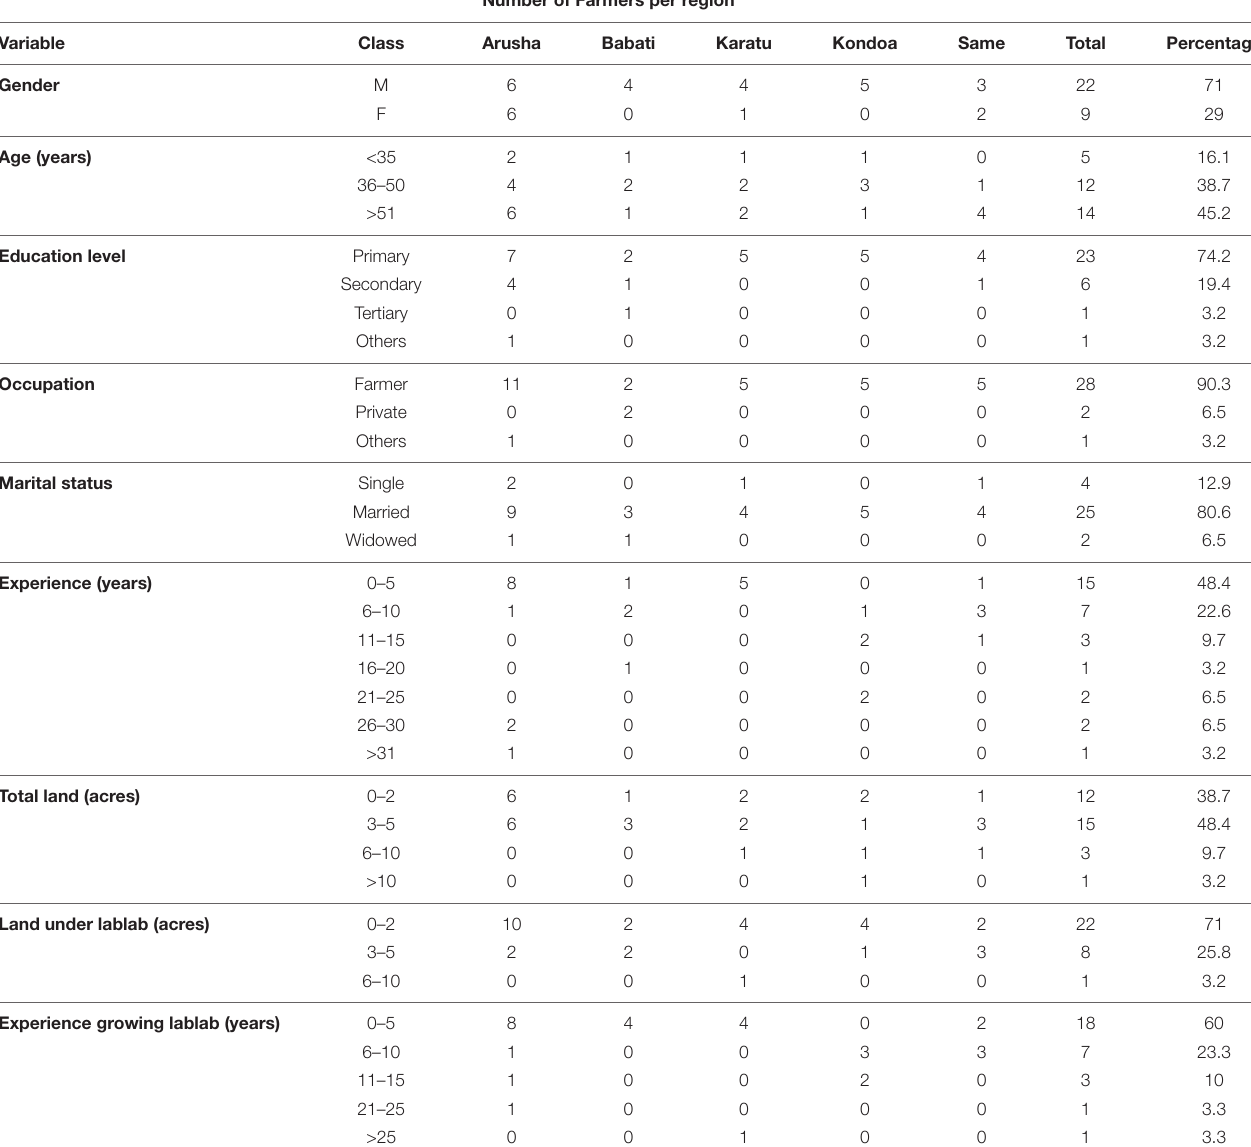
TABLE 1 | Description of the respondent’s socio-demographic